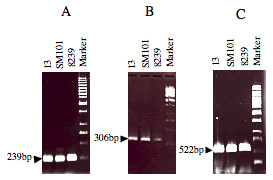
ssp PCR analysis of C. perfringens food poisoning isolates. Representative results of a PCR assay with primers designed to amplify ssp1 (A), ssp2 (B) or ssp3 (C) specific PCR products. Results are shown for control strain 13 (a known ssp1, 2 and 3-positive strain) and representative food poisoning isolates SM101 and NCTC8239. Marker indicates the migration of DNA size markers (Gene Ruler™ 1-kb ladder; Fermentas).